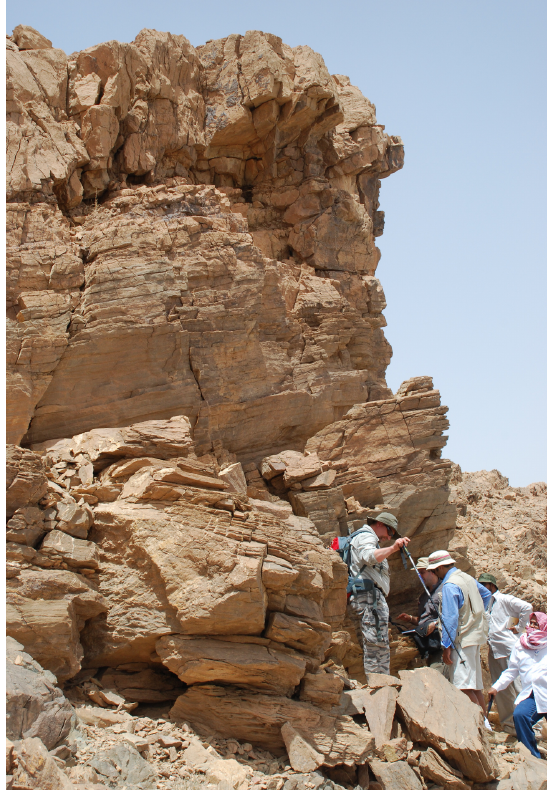
Figure 17. Farida formation, Murdama group, Jabal Farida. View of well-bedded dolomitic limestone in the lower part of the carbonate succession at the eastern margin of the Murdama group in the Maslum basin. Geologists from the Saudi Geological Survey, the Polish Geological Survey, and Adelaide University for